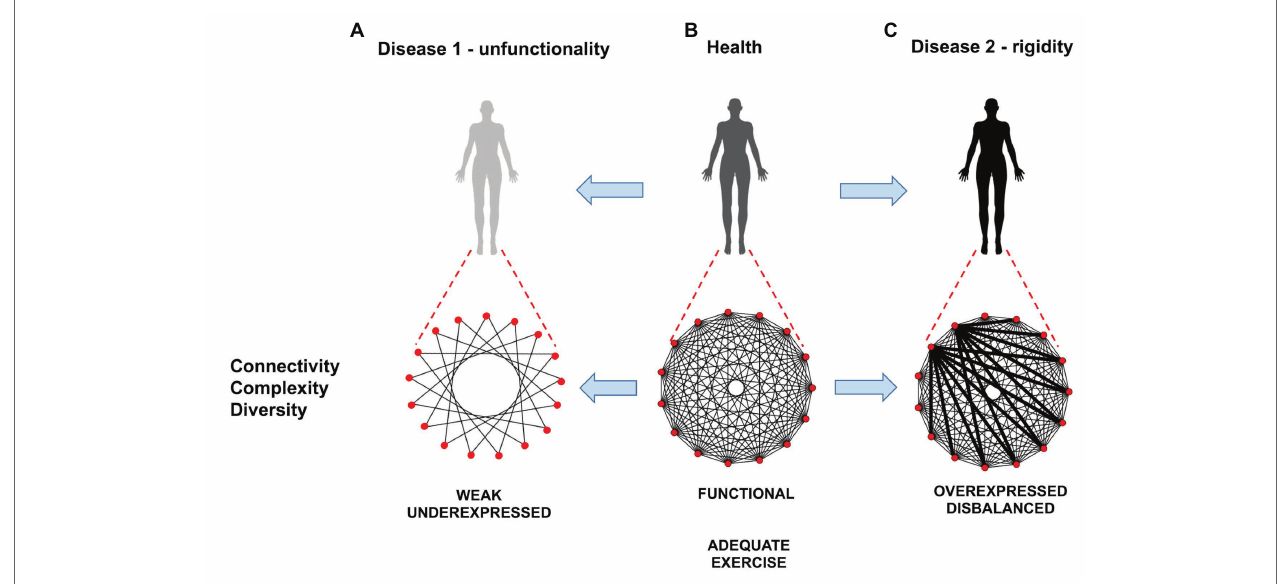
FIGURE 3 | Effects of exercise on functional physiological network connectivity, complexity, diversity. From left to right: (A) weak or underexpressed connectivity, corresponding to unfunctional state, (B) : functional connectivity, corresponding to healthy, fit state, and (C) underexpressed connectivity, corresponding to unfunctional state. Red nodes represent the different physiological network components and the links among them the couplings. The strength of the couplings is illustrated by the thickness of the